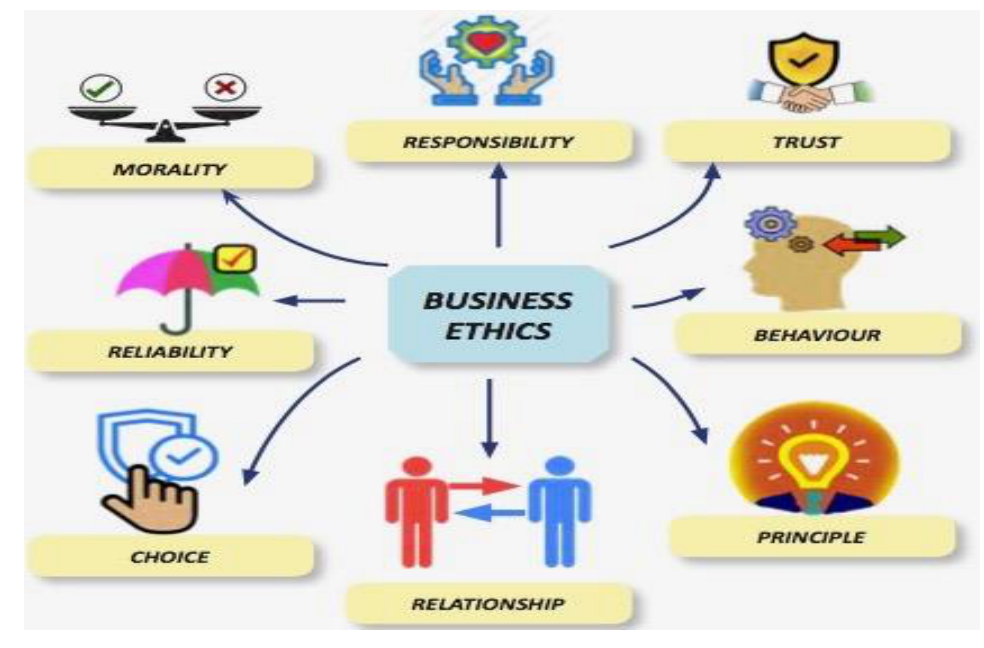
Figure 3: Business Ethics Source: Economics Class X (REC, 2020, P.